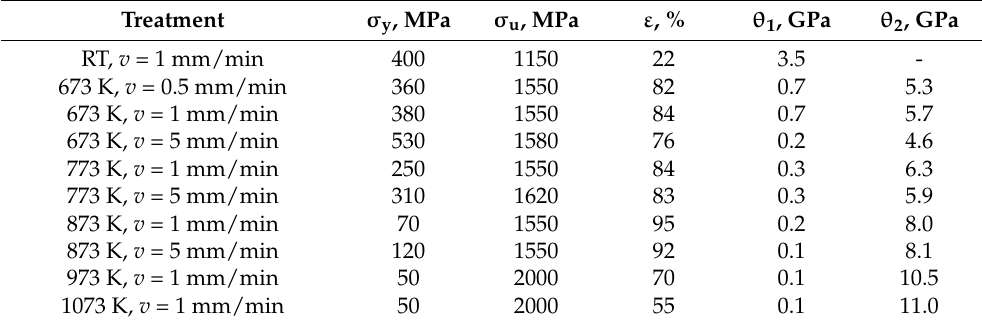
Table 1. Mechanical characteristics of the Cu-14Al-4Ni alloy after MPC at various temperatures and rates ( v